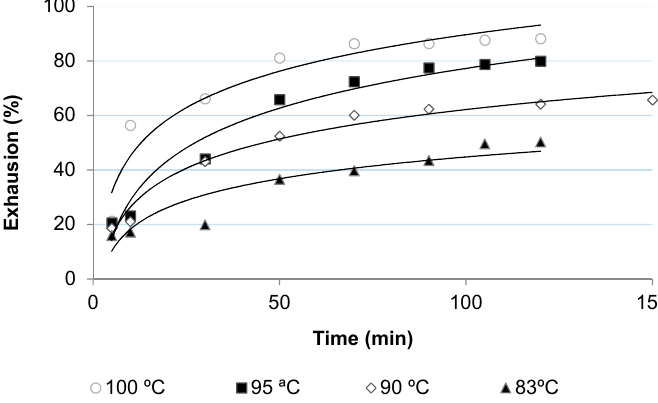
Figure 3. Dyeing kinetics for PES fabric dyed with Disperse Red 167 and o -vanillin.